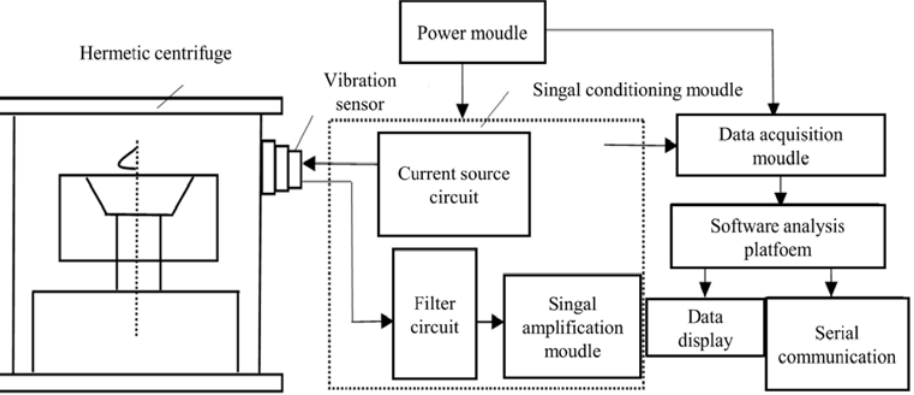
Fig. 1. The structure diagram of the